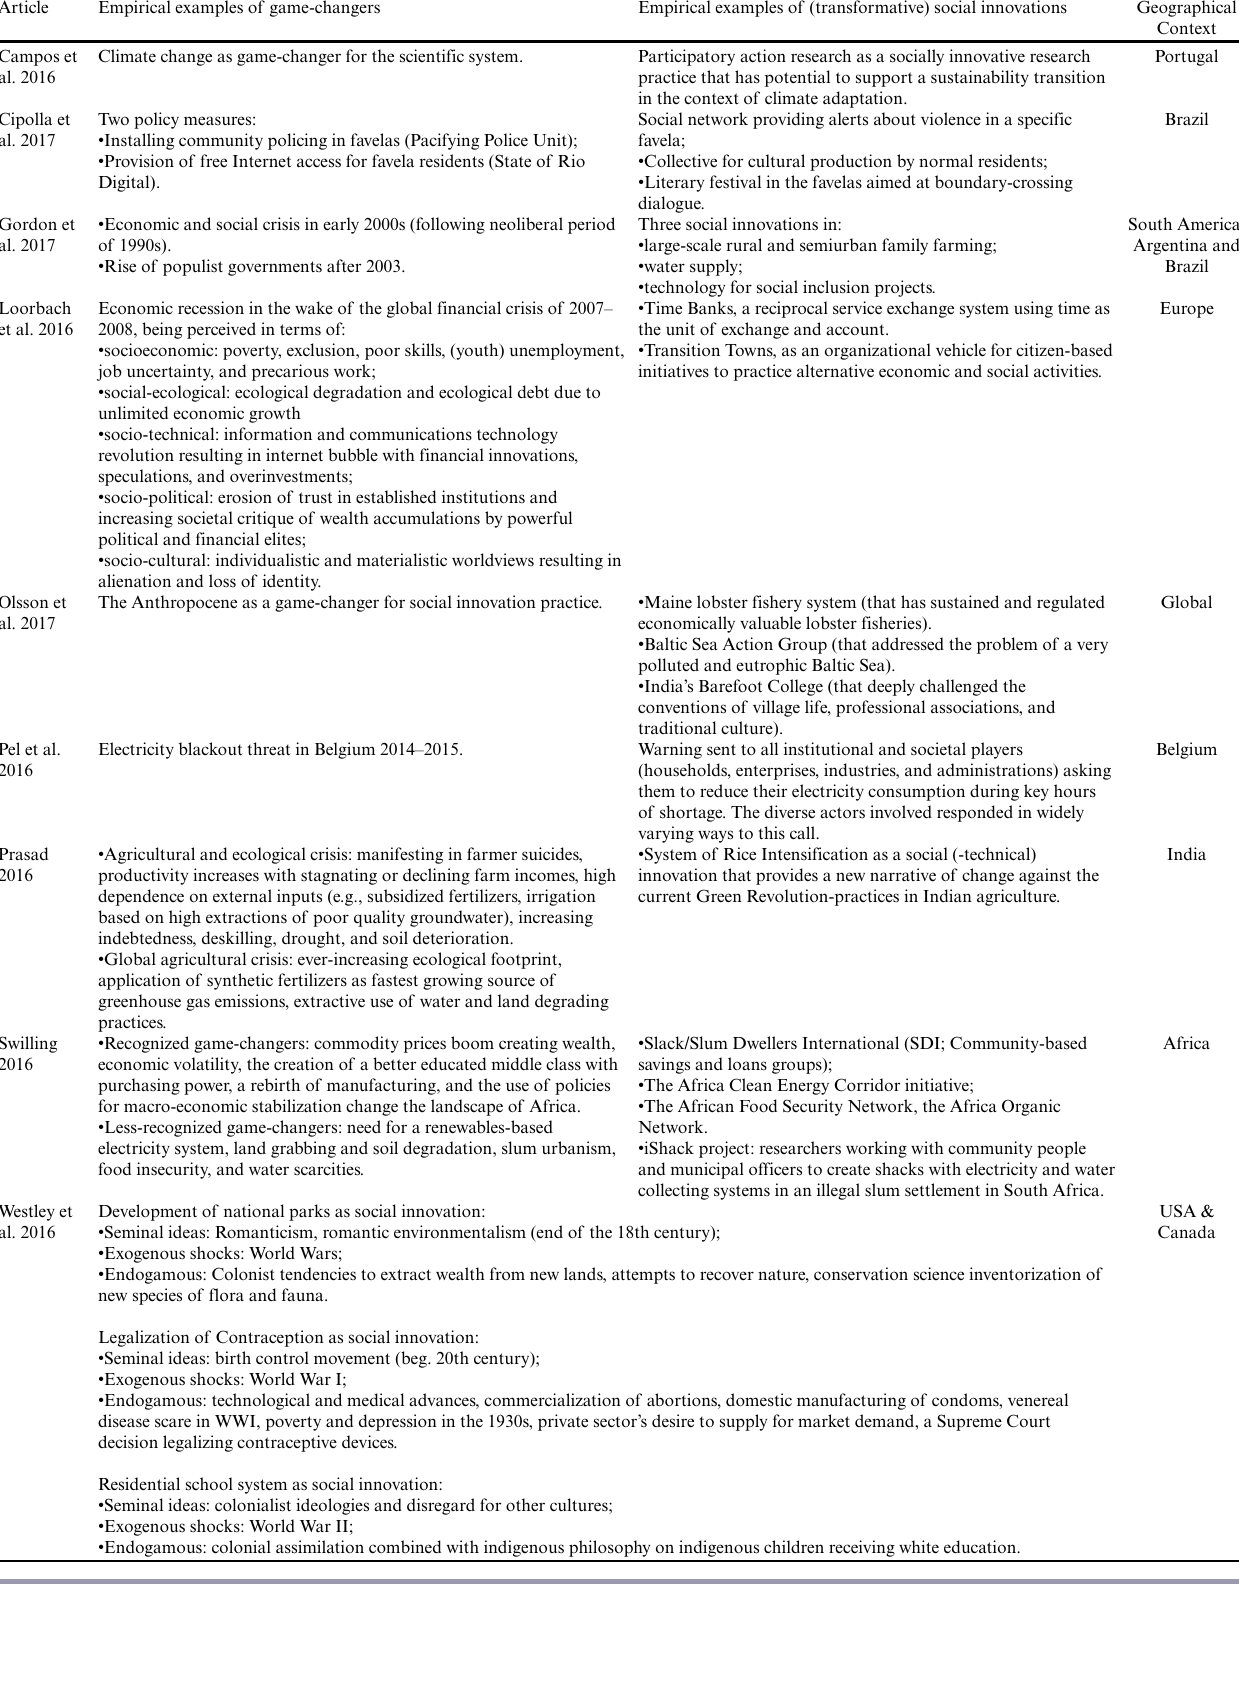
Table 1 . Empirical examples of game-changers and transformative social innovation across